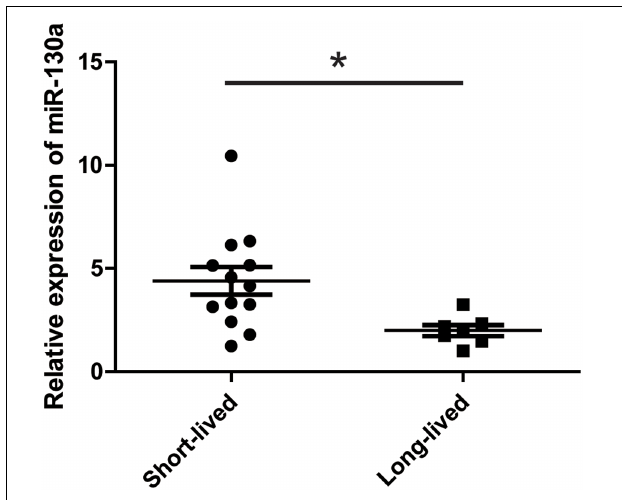
FIGURE 7 | miR-130a showed higher level in the short-lived mice treated with curcumin. Mice treated with curcumin in Figure 1A ( n = 20) was divided into two groups. Short-lived group indicated the mice lived less than 100 days ( n = 13) while long-lived group indicated the mice lived more than 100 days ( n = 7). Q-PCR showed the expression level of miRNAs in the serum of each mice. ∗ p < 0.05.